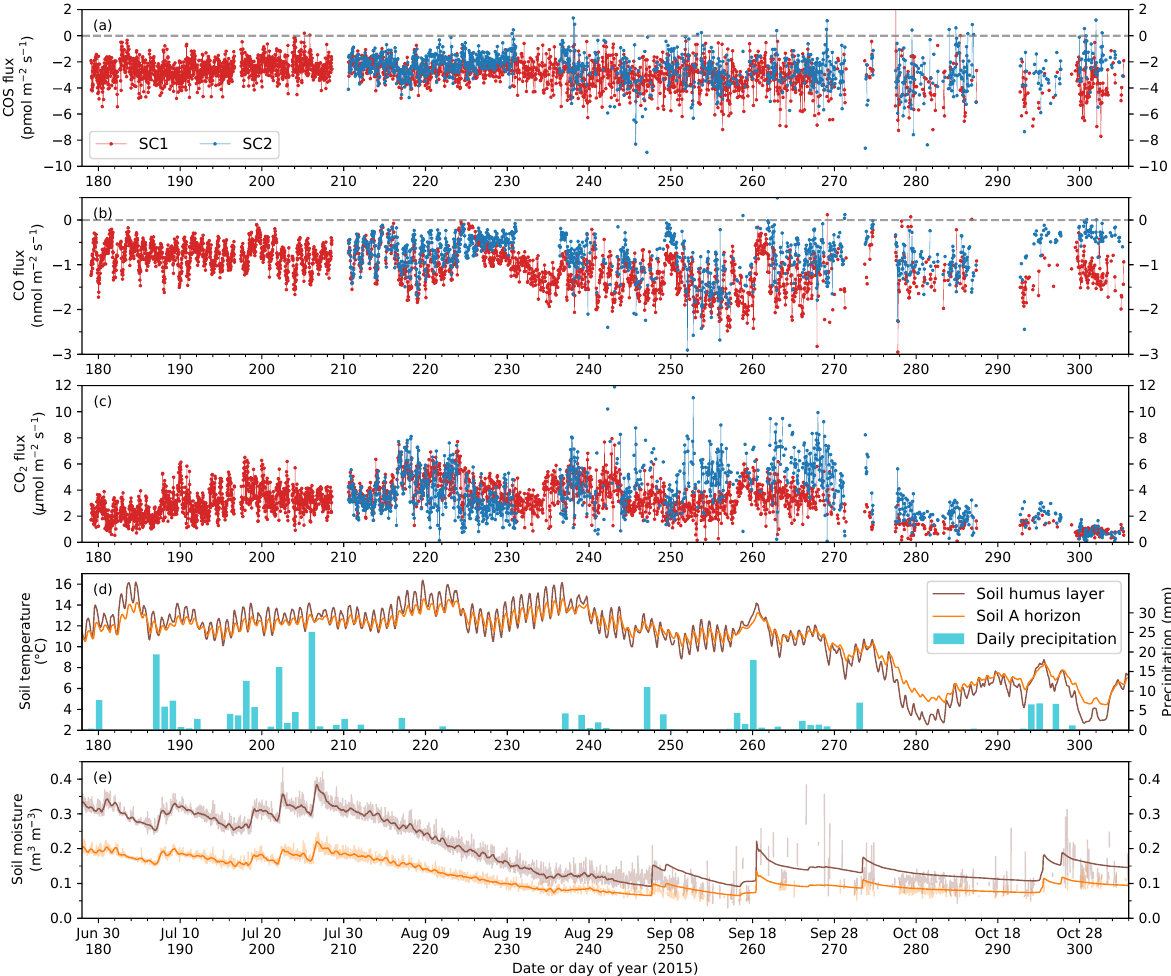
Figure 1. Soil fluxes of (a) COS, (b) CO, and (c) CO 2 from two chambers in a pine forest in southern Finland in summer and fall 2015. Also shown are (d) soil humus layer (1–5cm) and A horizon (2–5cm below the humus layer) temperatures (lines) and daily precipitation (bar plot), and (e) gap-filled and smoothed soil moisture in the humus layer and A horizon. Frequent gaps in raw soil moisture data (shown in transparent colors) from September 2015 onwards were gap-filled (solid lines) based on the correlation with soil moisture from a nearby location (see Sect. 2.4 for